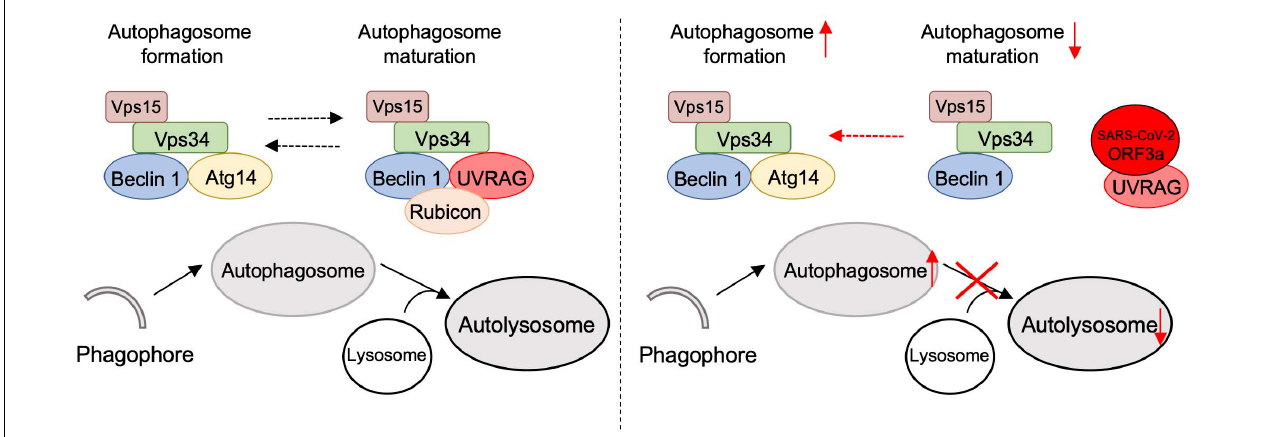
FIGURE 5 | Schematic diagram of SARS-CoV-2 ORF3a-mediated incomplete autophagy. SARS-CoV-2 ORF3a interacts with UVRAG to positively regulate PI3KC3-C1 but suppress the PI3KC3-C2, leading to elevated autophagosome formation but blockage of autophagosome